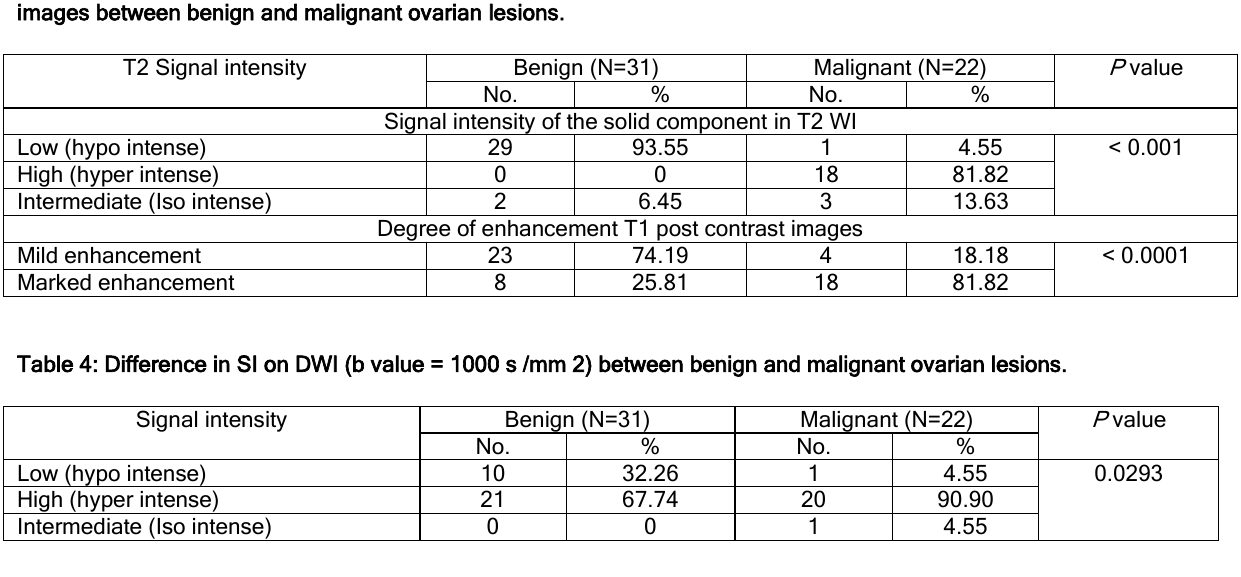
Table 3: Difference in signal intensity of solid component in T2 WI MRI and degree of enhancement on T1 post contrast images between benign and malignant ovarian lesions.